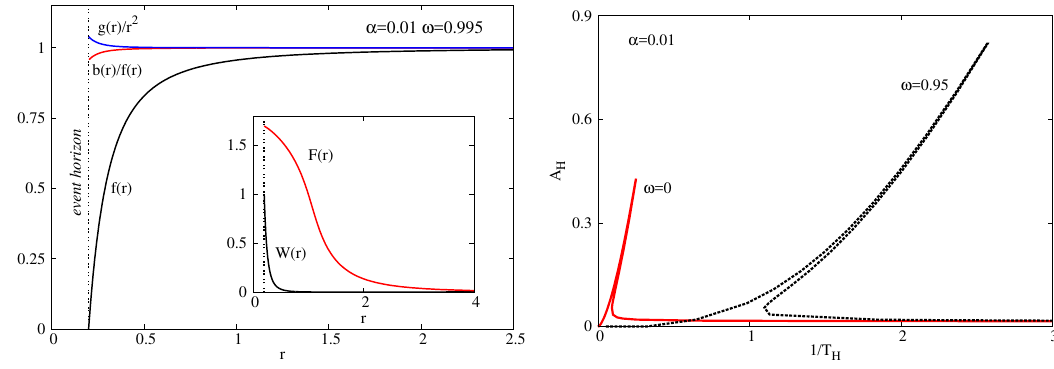
Figure 10 . Left panel: the pro(cid:12)le functions of a typical spinning BH with Skyrme hair. Right panel: the (horizon area-temperature) diagram is shown for two sets of